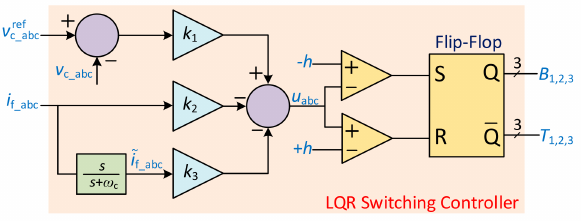
Figure 4. LQR-based switching and voltage